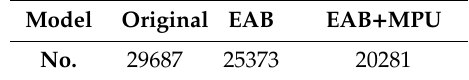
Table 6. The number of sequences under di ff erent